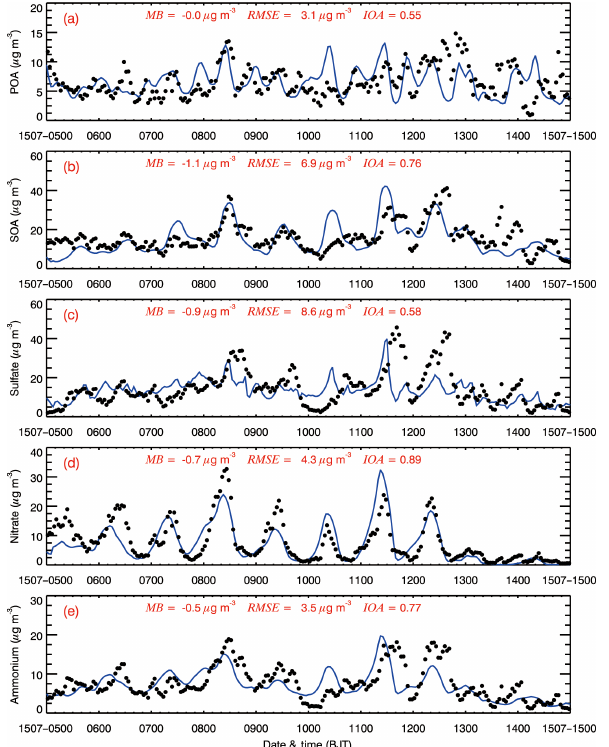
Figure 4. Comparison of measured (black dots) and simulated (black line) diurnal profiles of submicron aerosol species of (a) POA, (b) SOA, (c) sulfate, (d) nitrate, and (e) ammonium at NC- NST site in Beijing from 5 to 14 July 2015.